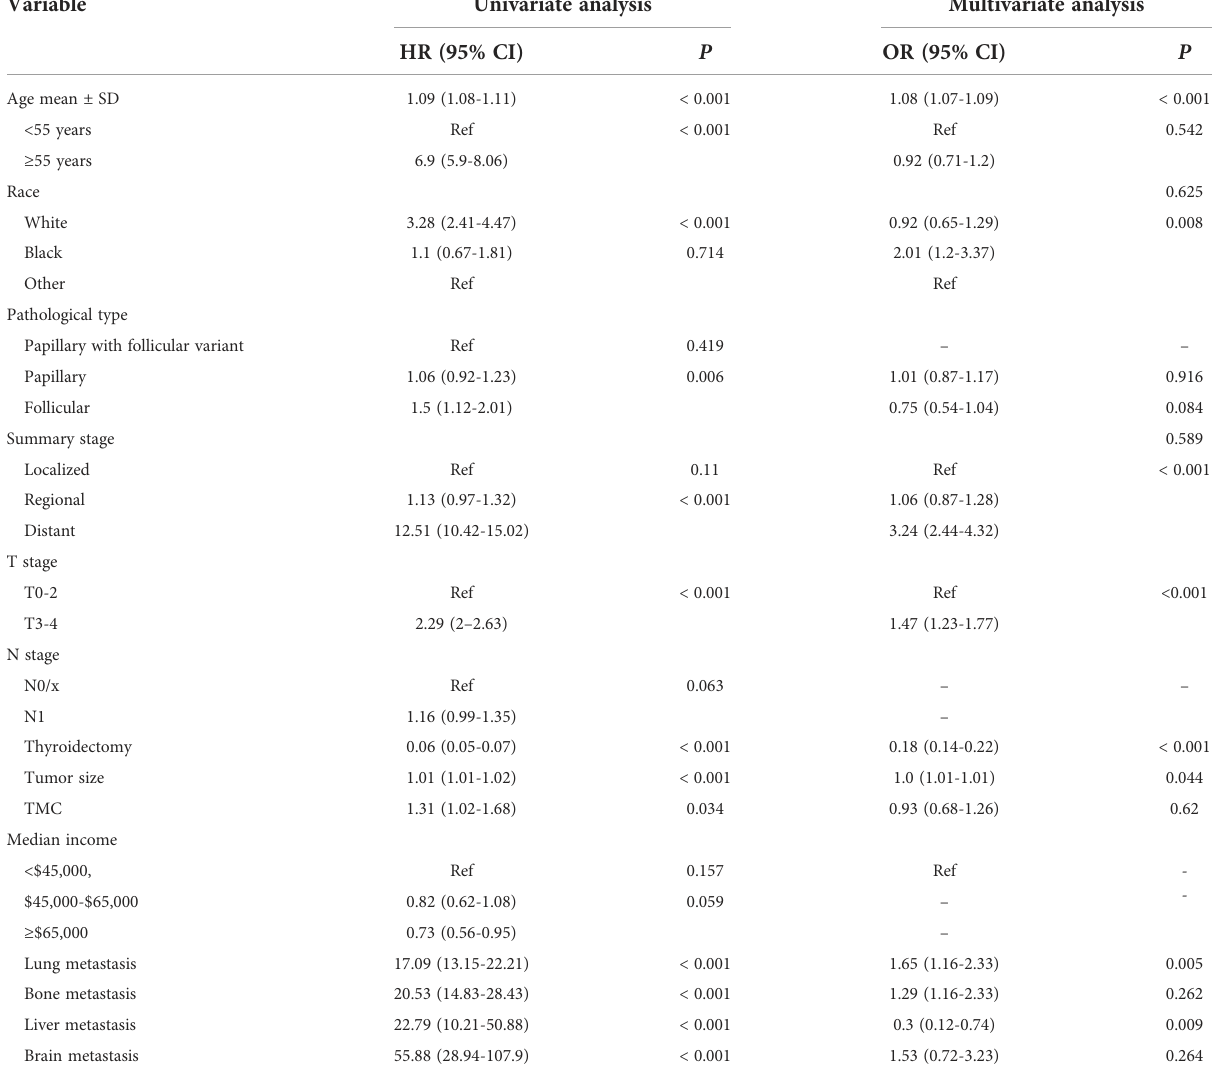
TABLE 5 Univariate and multivariate cox regression analyses of the prognostic factors of OS in FDTC patients.